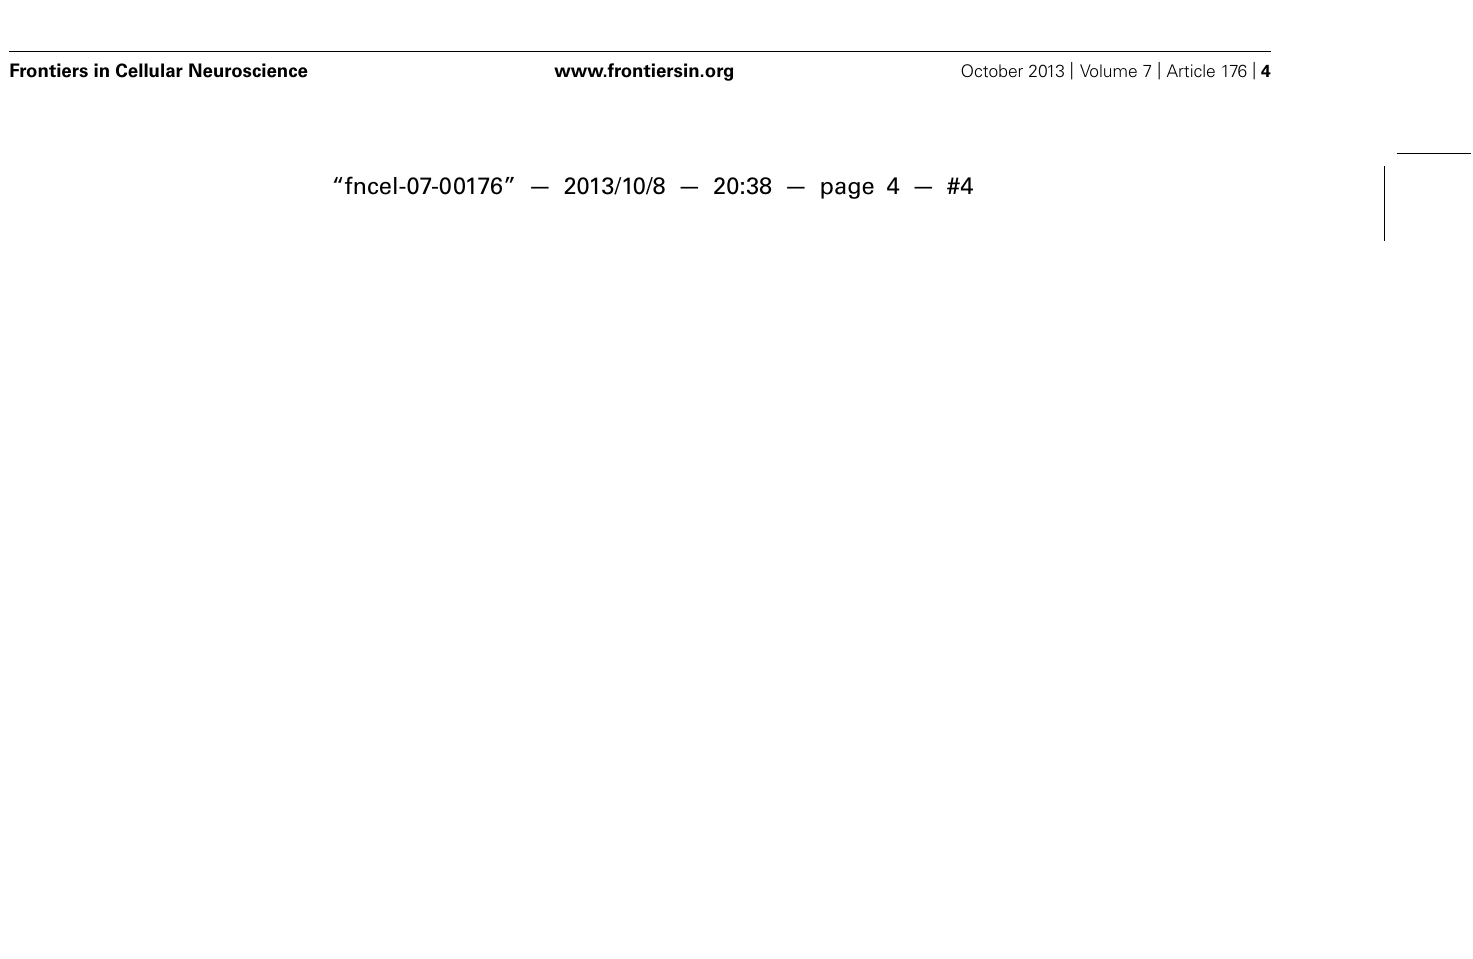
measured following activation of PA-GFP in a small area of the mitochondrial network. Shown is one representative picture and the average of three independent experiments with 15 cells each/condition. Statistical significance was analyzed using Student’s t -test with ** marking p < 0.01. Error bars represent